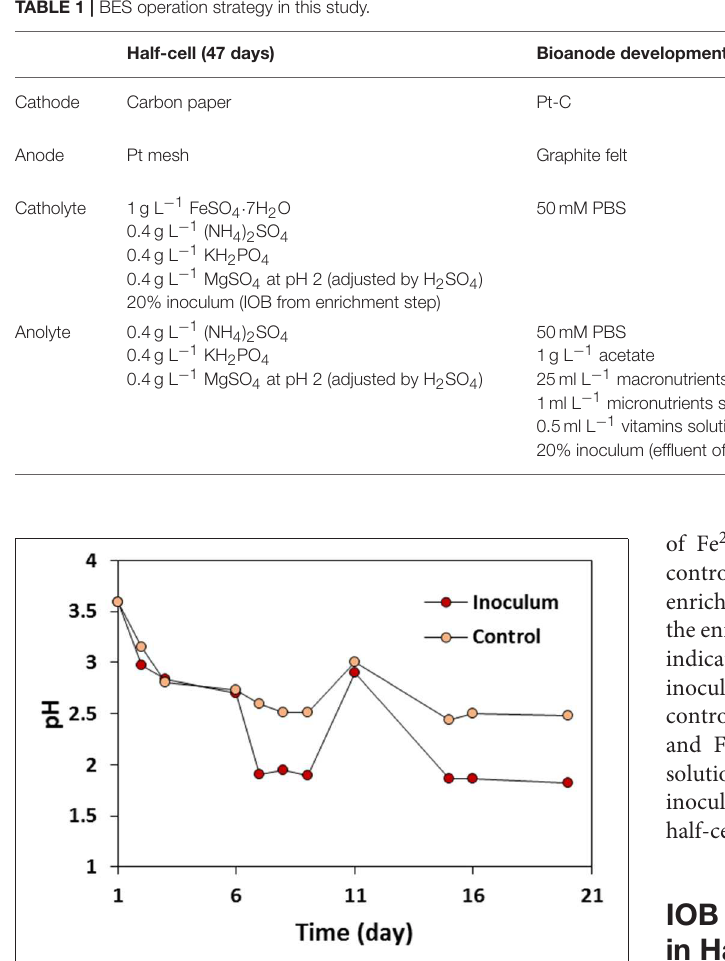
FIGURE 2 | pH of the inoculated and control solutions during the enrichment